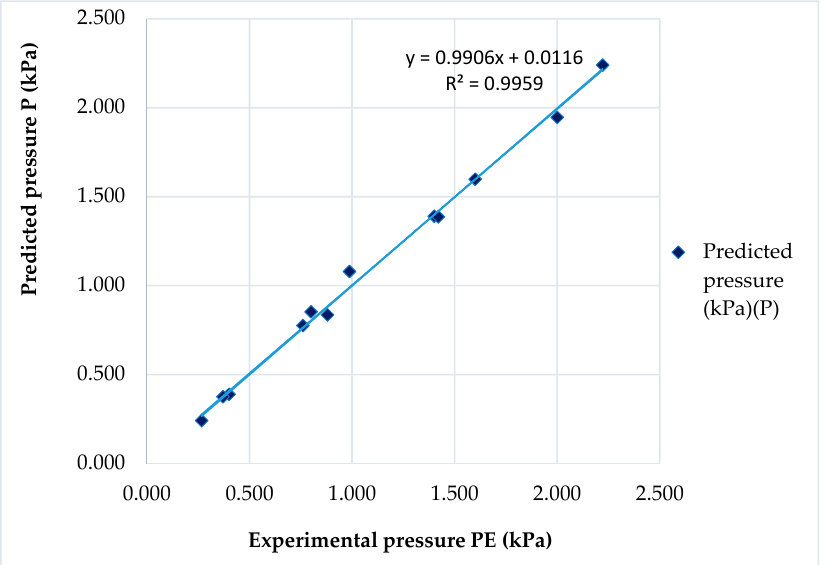
Figure 9. Comparison of predicted compression pressure (P) with experimental results (P E ).